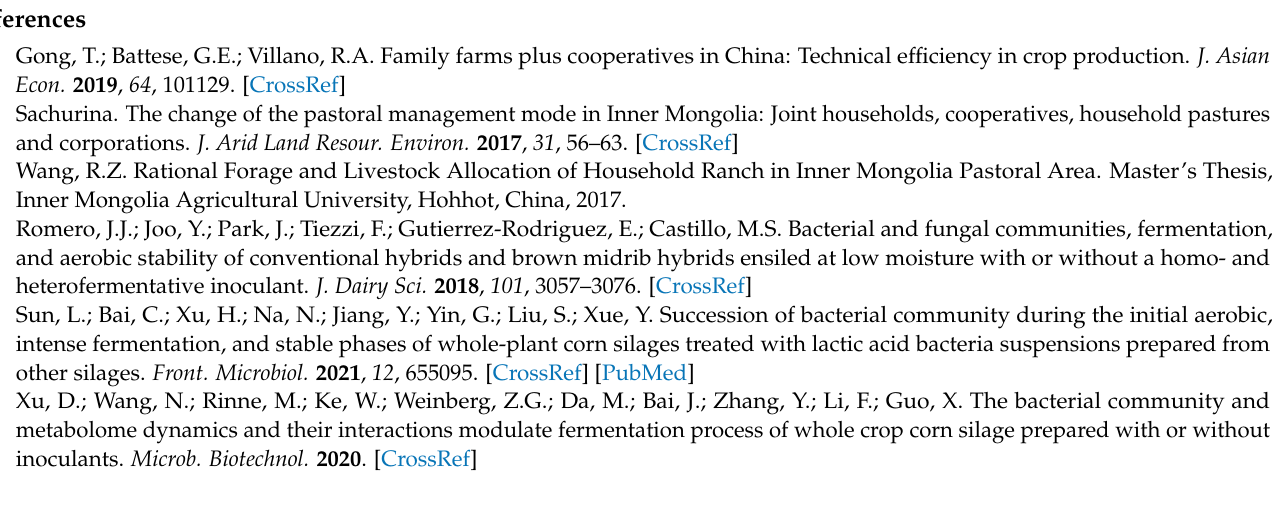
Supplementary Table S5. Relative abundance of Bacillus , Pseudomonas , Escherichia , Klebsiella , and Salmonella in whole-plant corn silages (n = 3). S1, silage collected from Erdos; S2, silage collected from Baotou; S3, silage collected from Ulanqab; S4, silage collected from Hohhot. (page: